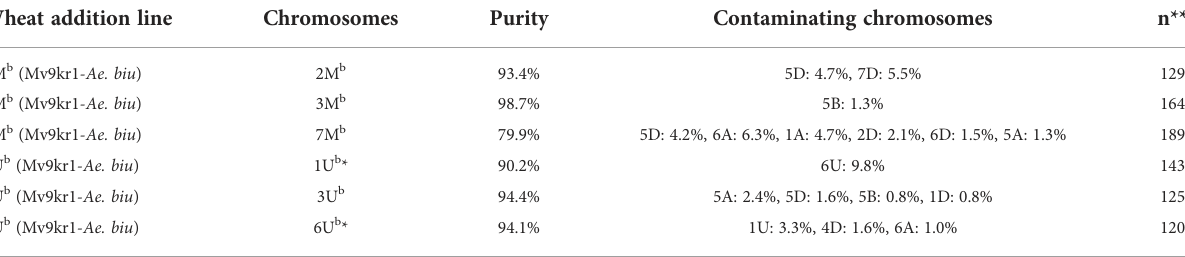
TABLE 1 Purity in M b - and U b -genome chromosome fractions fl ow sorted from Mv9kr1- Ae. biuncialis acc. MvGB642 disomic addition lines. Wheat addition